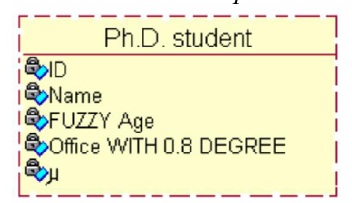
Fig. 1. Representation of a fuzzy